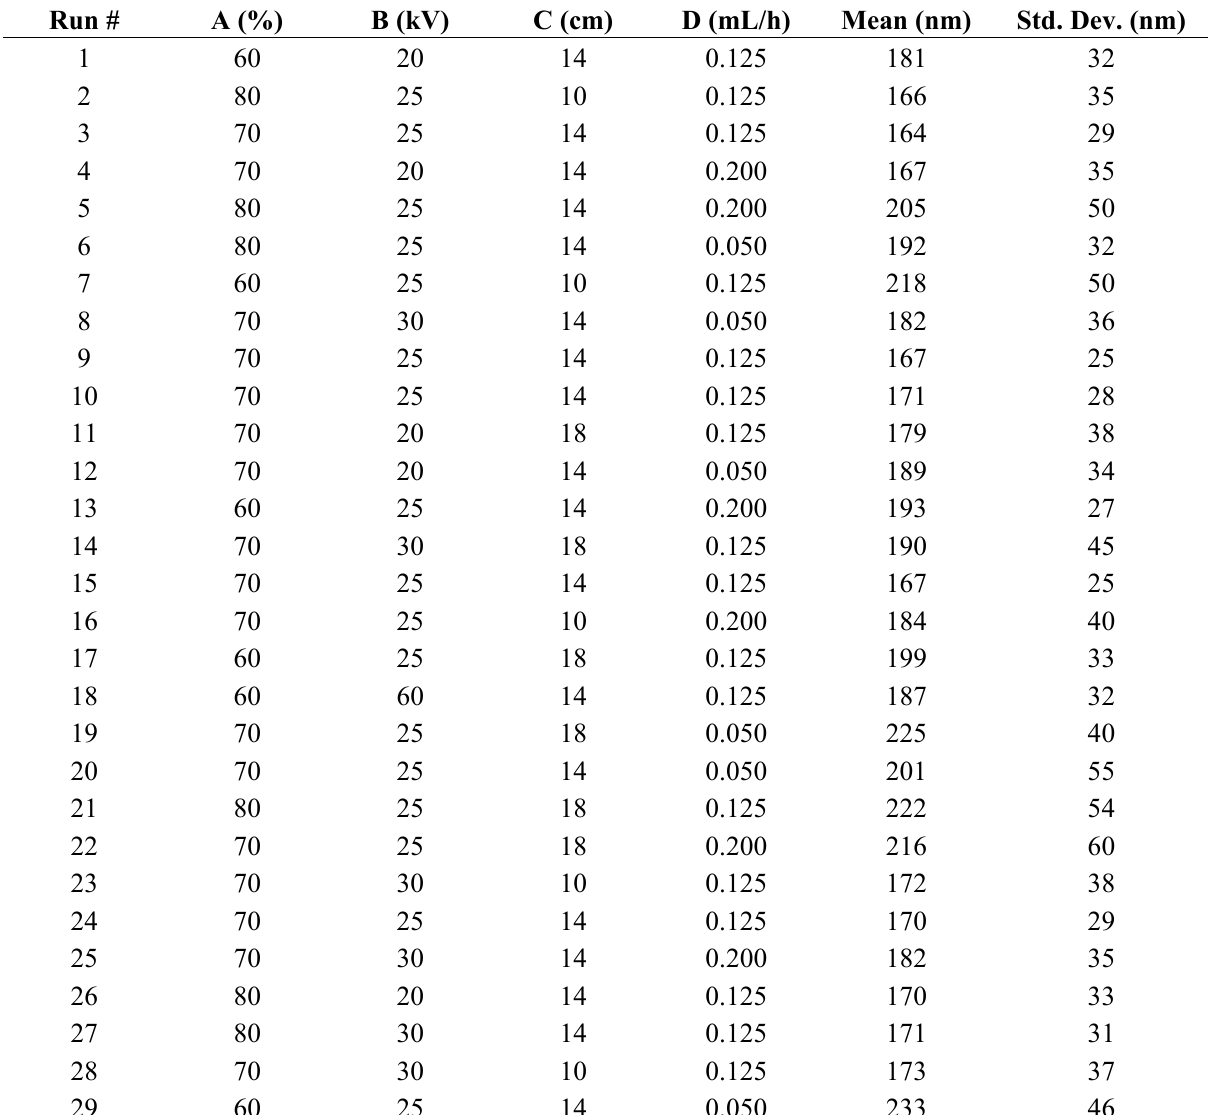
Table 5. Experimental matrix for the Box-Behnken